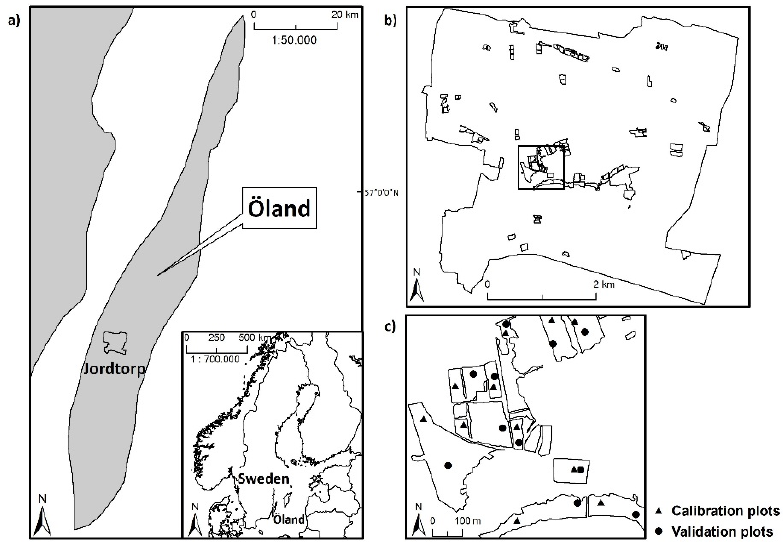
Figure 1. ( a ) The location of the study area on the Baltic Island of Öland, Sweden; ( b ) the distribution of grassland sites included in the present study ( n = 52); ( c ) an example of the distribution of field plots within some of the grassland sites.